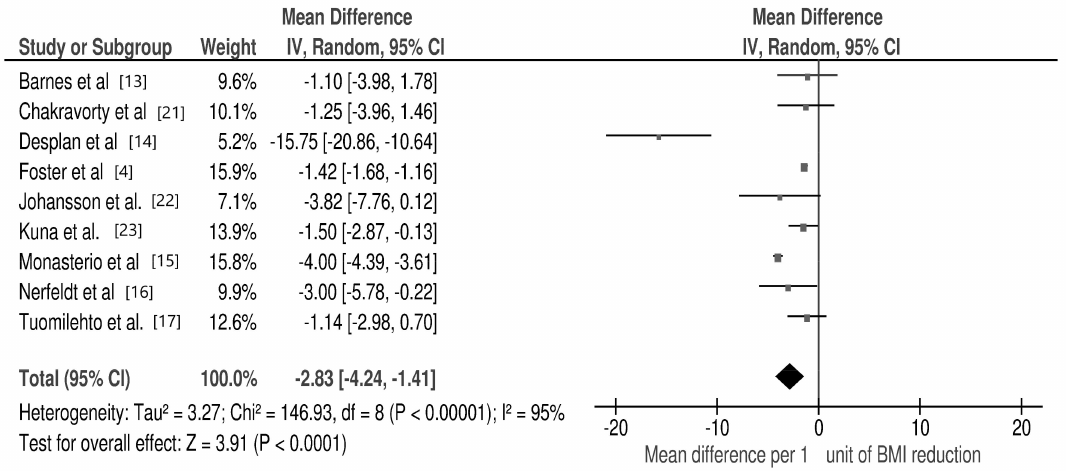
Figure 2. Forest plot for mean apnea–hypopnea index (AHI) change per 1 unit of body mass index (BMI) reduction in selected